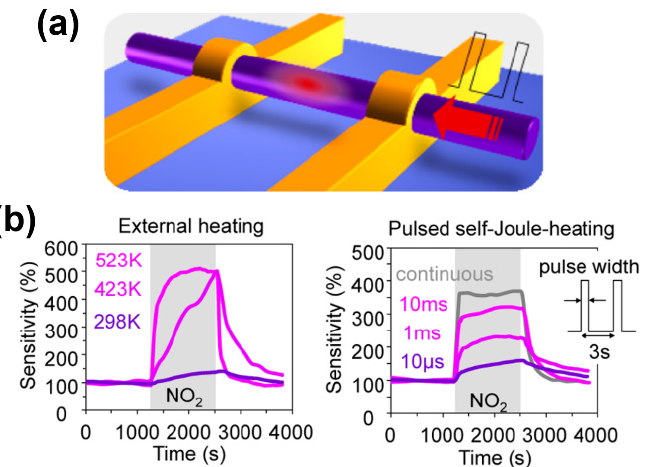
Figure 28. ( a ) Suspended nanowire device; and ( b ) comparison between the conventional external heating device and pulsed self-joule-heating device. Reprinted from reference [220] with permission from the American Chemical Society.